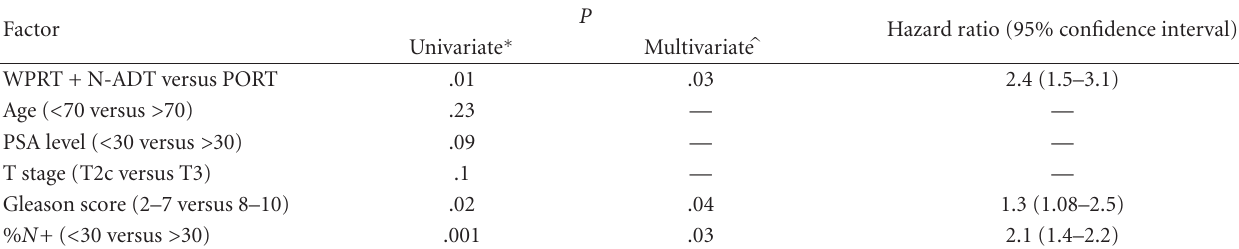
Table 3: Univariate and multivariate analysis of clinical and treatment factors predicting for cause specific survival ( n = 162). P Factor Hazard ratio (95% confidence interval) Univariate ∗ Multivariate